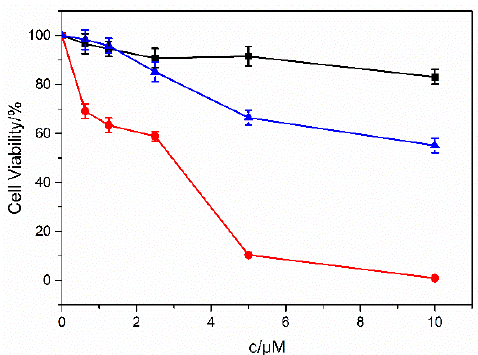
Figure 4. The viability change of NIH/3T3 cells when incubated with different concentrations of BR2 ( ■ ), FB ( ▲ ) and VBB ( ● ) dyes. ( n = 5).